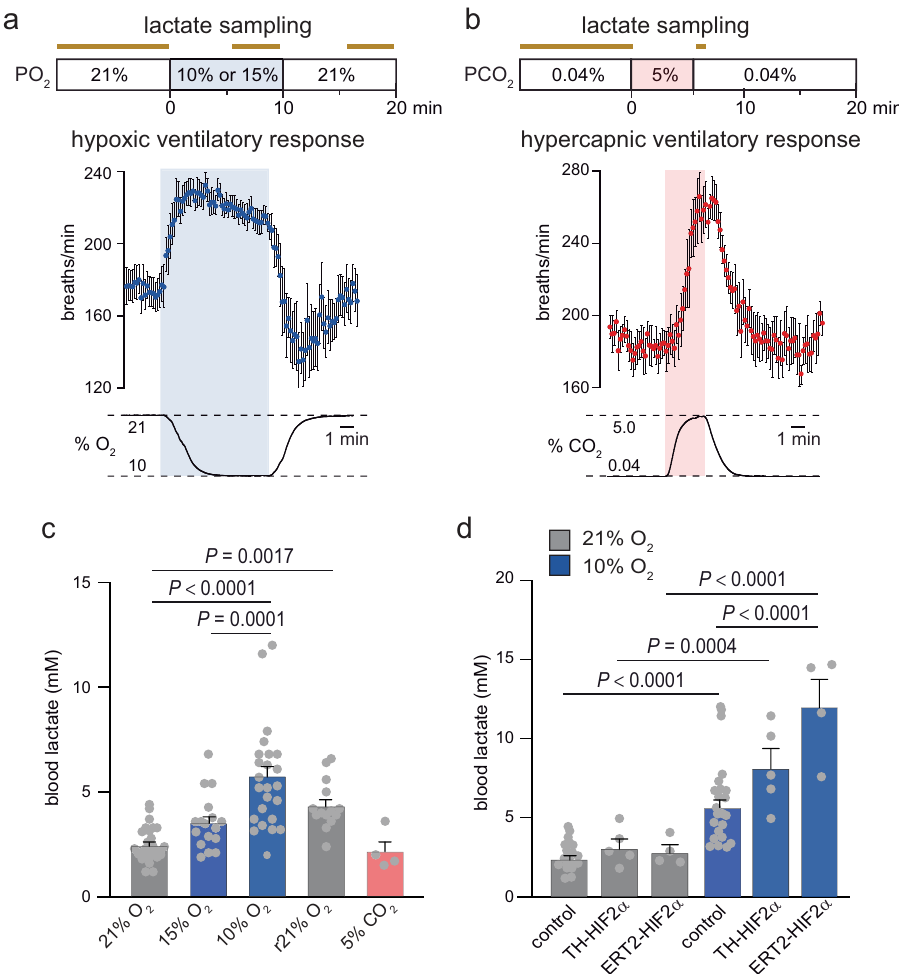
Fig. 1 Blunting of hypoxia-induced lactatemia by arterial chemoreceptors. a , b Top. Scheme of the experimental protocol followed to measure blood lactate (lactate sampling indicated by horizontal brown bars) under normoxic conditions (21% O 2 ) and during exposure to hypoxia (10% or 15% O 2 tension, pale blue) or hypercapnia (5% CO 2 , pale red). Bottom. Plethysmographic recordings showing the average increase in respiratory frequency (breaths/min) during exposure to hypoxia (blue dots; n = 35 mice) or hypercapnia (red dots; n = 27 mice). c Scatter plots of blood lactate levels measured in the various experimental conditions. Values (mean ± SEM) are: normoxia (2.5 ± 0.1 mM, n = 29 mice; gray), hypoxia 15% O 2 (3.6 ± 0.3 mM, n = 17 mice; blue), hypoxia 10% O 2 (5.8 ± 0.5 mM, n = 23 mice; blue), recovery in normoxia (r21% O 2 measured 5 min after returning to normoxia; 4.4 ± 0.3 mM, n = 14 mice; gray), and hypercapnia (2.2 ± 0.5 mM, n = 4 mice; pale red). P -values calculated by one-way ANOVA followed by Tukey ’ s multiple comparisons post hoc test are indicated. d Scatter plots of blood lactate levels, during normoxia (gray) and hypoxia (blue), in control and mice with carotid body dysfunction due to embryonic or conditional adult de fi ciency of Hif2 α . P -values calculated by one-way ANOVA followed by Tukey ’ s multiple comparisons post hoc test are indicated. Mean± SEM values are: TH-HIF2 α (normoxia = 3.2 ± 0.6 mM; hypoxia 10% O 2 = 8.3 ± 1.2 mM, n = 5 mice); ERT2-HIF2 α (normoxia 2.9 ± 0.4 mM; hypoxia 10% O 2 = 12.3 ± 1.7 mM, n = 4 mice). Source data are provided as a Source data fi